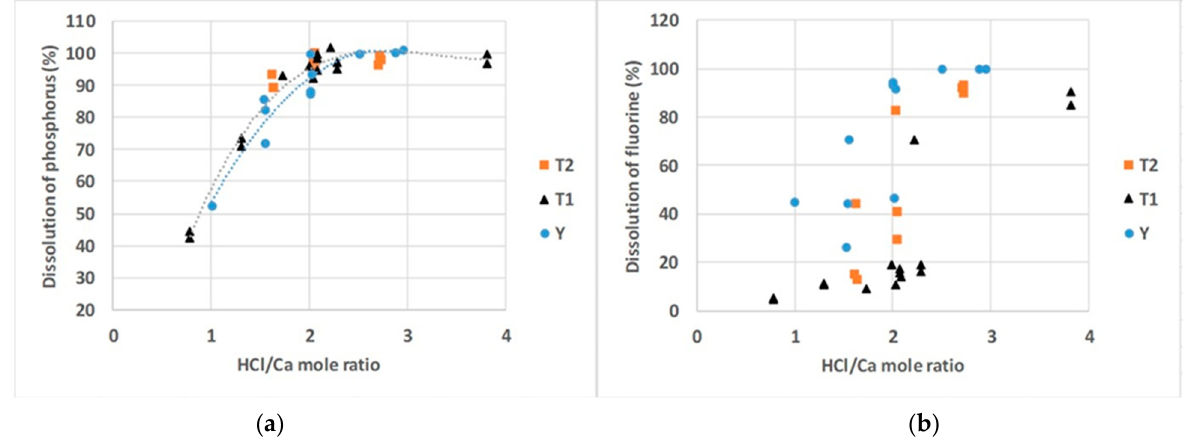
Figure 2. Dissolution of phosphorus ( a ) and fluorine ( b ) depending on HCl dosage where T1—Toolse 1, T2—Toolse 2, and Y—Ülgase.